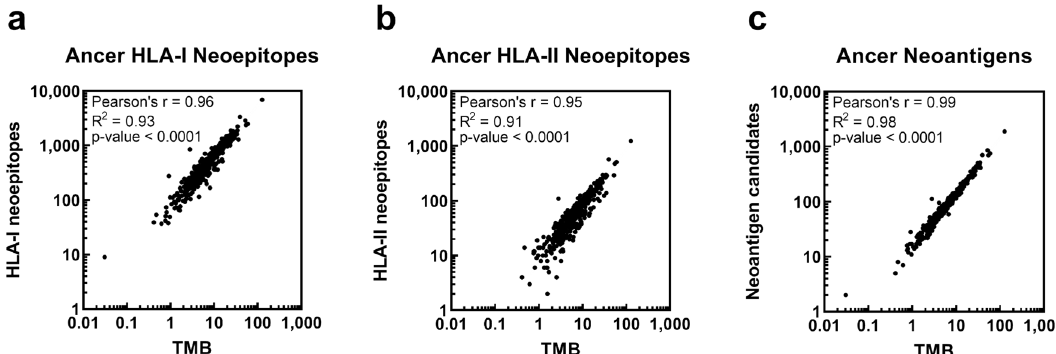
Figure 2. Association between mutational and neoepitope landscapes. BLCA mutanomes were analyzed with Ancer to determine counts of Ancer-defined HLA class I neoepitopes ( a ), Ancer-defined HLA class II neoepitopes ( b ), and Ancer-defined neoantigen candidates that could be used for precision immunotherapy purposes ( c ). Numbers of HLA class I neoepitopes, HLA class II neoepitopes, and neoantigen candidates observed in each patient is strongly correlated with observed tumor mutational burden (TMB). Each dot corresponds to one TGCA BLCA